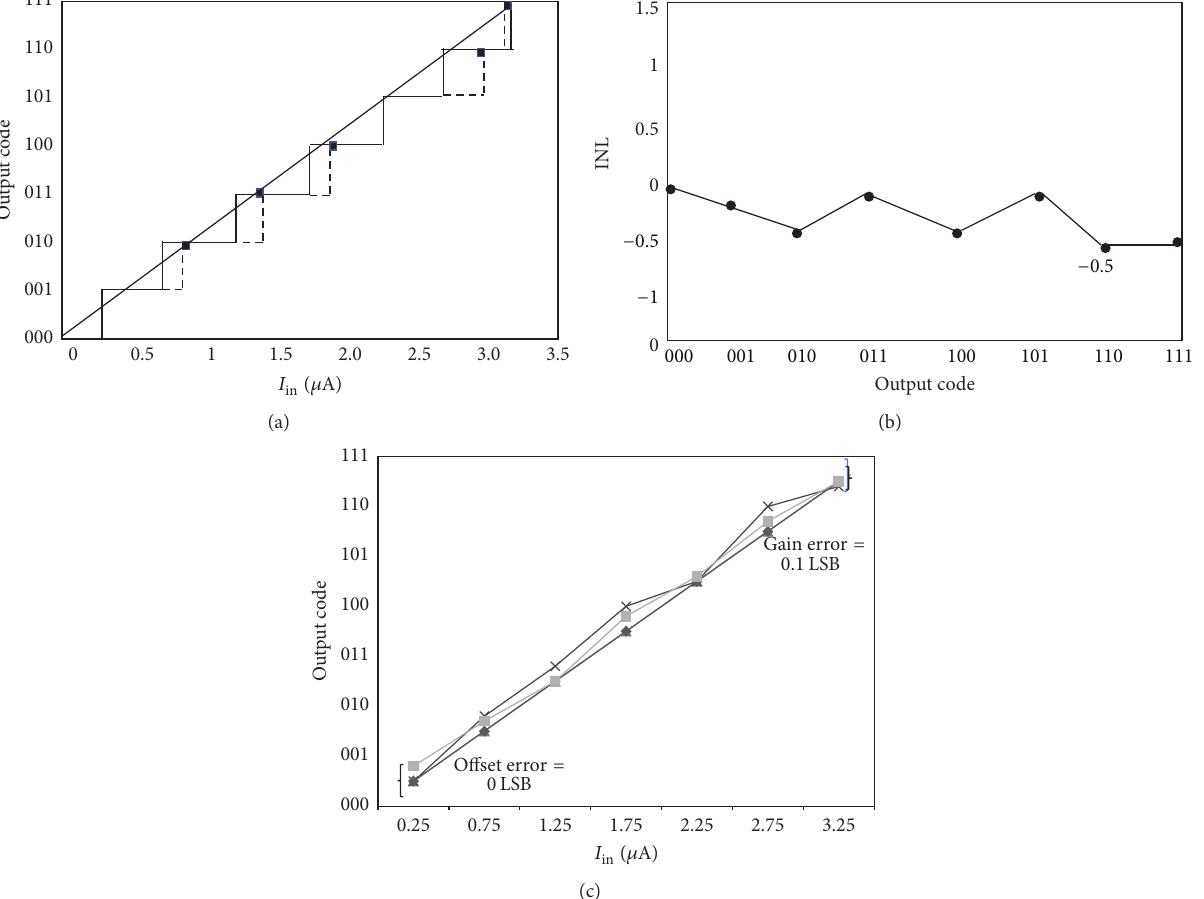
Figure 17: (a) Transfer characteristics with best fit line for two-step flash ADC using proposed comparator and (b) INL versus output code.